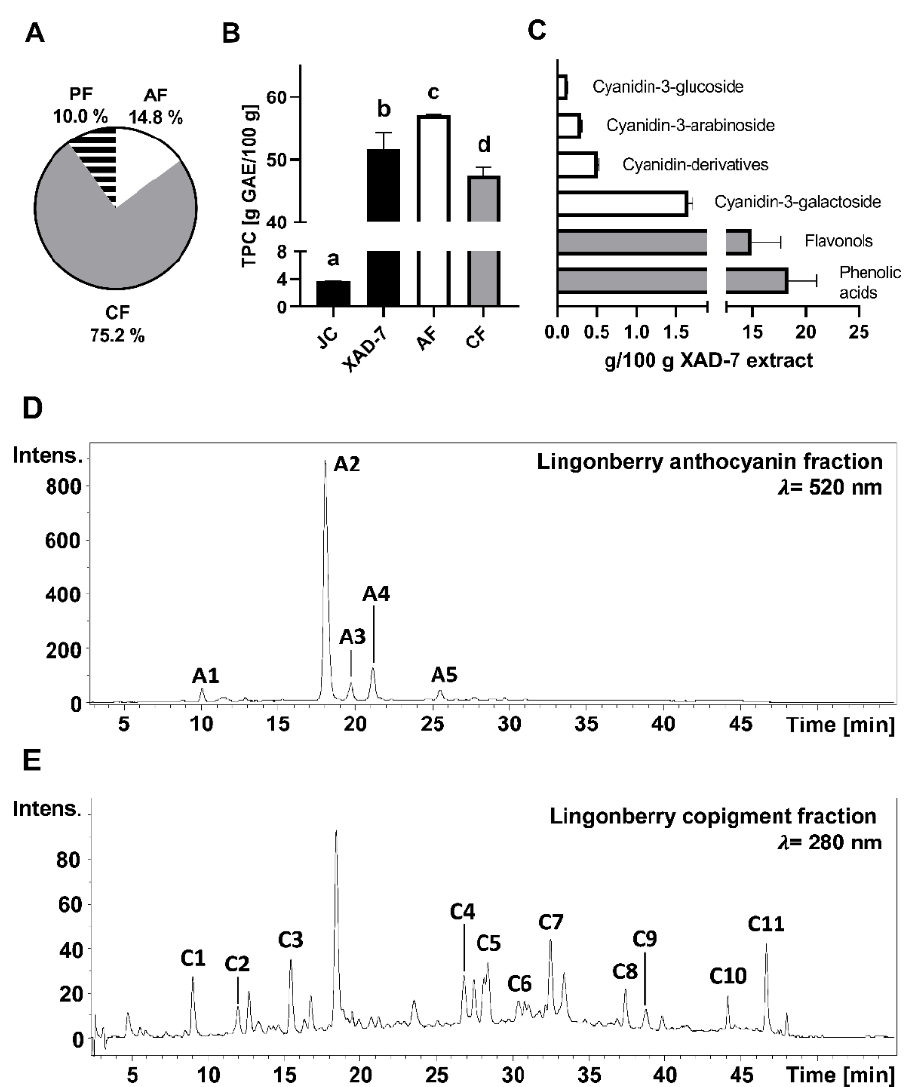
Figure 1. Chemical characterization of lingonberry juice concentrate (JC), the XAD-7 extract, the anthocyanin fraction (AF) and the copigment fraction (CF). Mean ± standard deviation; n = 3. ( A ) Composition of lingonberry XAD-7 extract. ( B ) Total phenolic content (TPC) of JC, XAD-7 extract, AF and CF. Different letters represent statistically significant differences ( p < 0.05) within the samples. ( C ) Concentration of the main phenolic compounds in the XAD-7 extract. ( D ) HPLC chromatogram of AF. ( E ) HPLC chromatogram of CF. Identification of HPLC peaks is given in Table 1. Intens.: signal intensity (mAU).